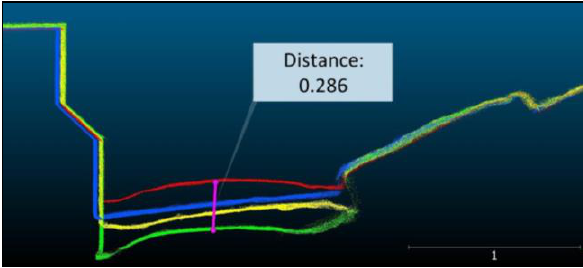
Figure 14 . Topographic variations for cross-section C1